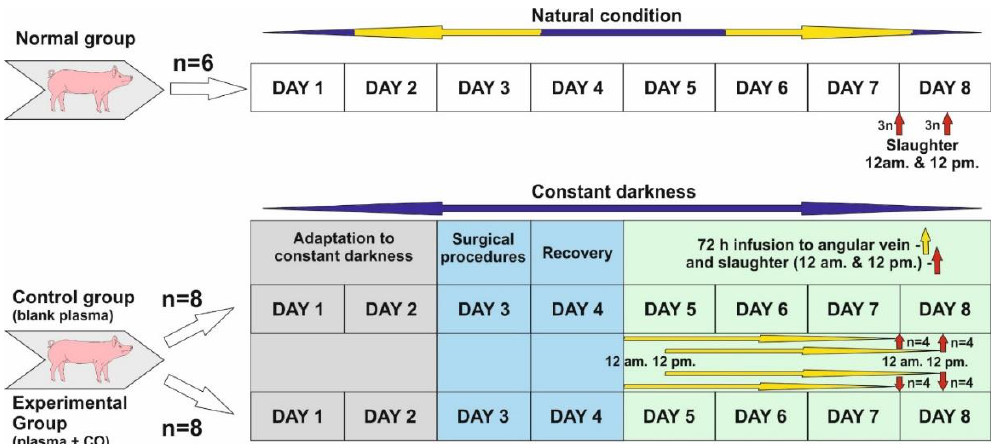
Figure 8. Schematic draw of experiment.